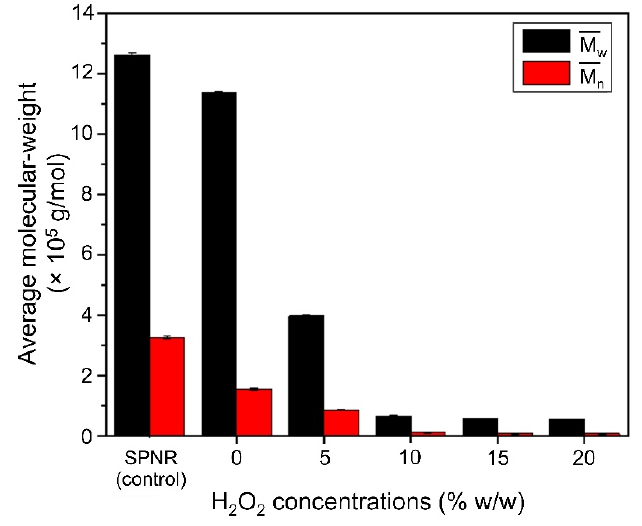
Figure 6. The average MW of SPNR and the samples prepared by introducing 2.0 phr of TiO 2 powder with various H 2 O 2 concentrations after UVC-irradiation for 5 h.